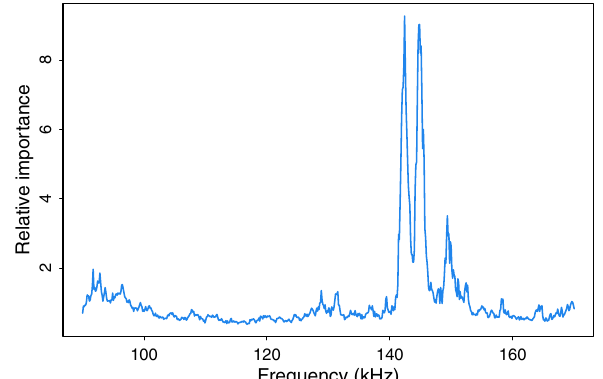
Figure 5. Relative importance (measured by the Gini index) of the different frequencies from 90 to 170 kHz for random forest classification of stickleback and whitefish.